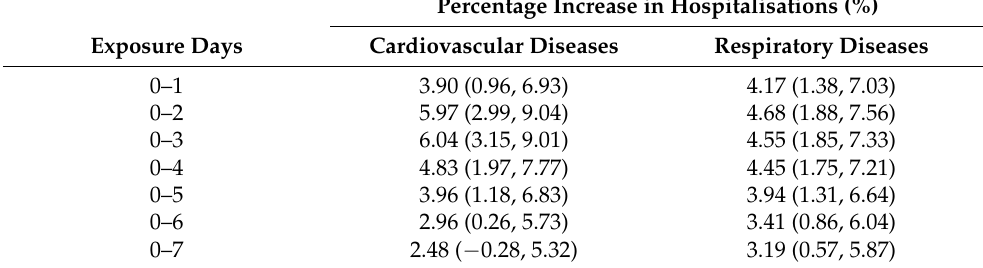
Table 3. Percent change (mean and 95% CI) of CVD and RD hospitalisations associated with an interquartile range (IQR) increase in temperature variability ( ◦ C) on different exposure days for all ages combined; models were not adjusted for any